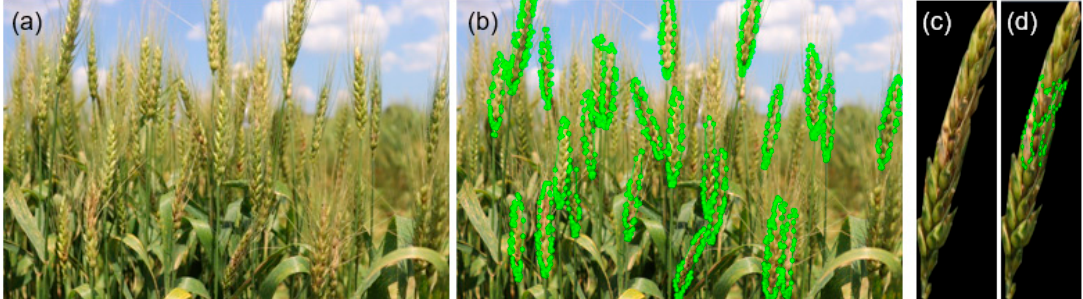
Figure 1. An example of manual annotation of target images; ( a ) a typical full-size image of spikes from a single planted row of wheat in the field; ( b ) the same image with annotated wheat spikes; ( c ) a segmented sub-image of a single wheat spike; ( d ) the individual wheat spike with annotated diseased areas.